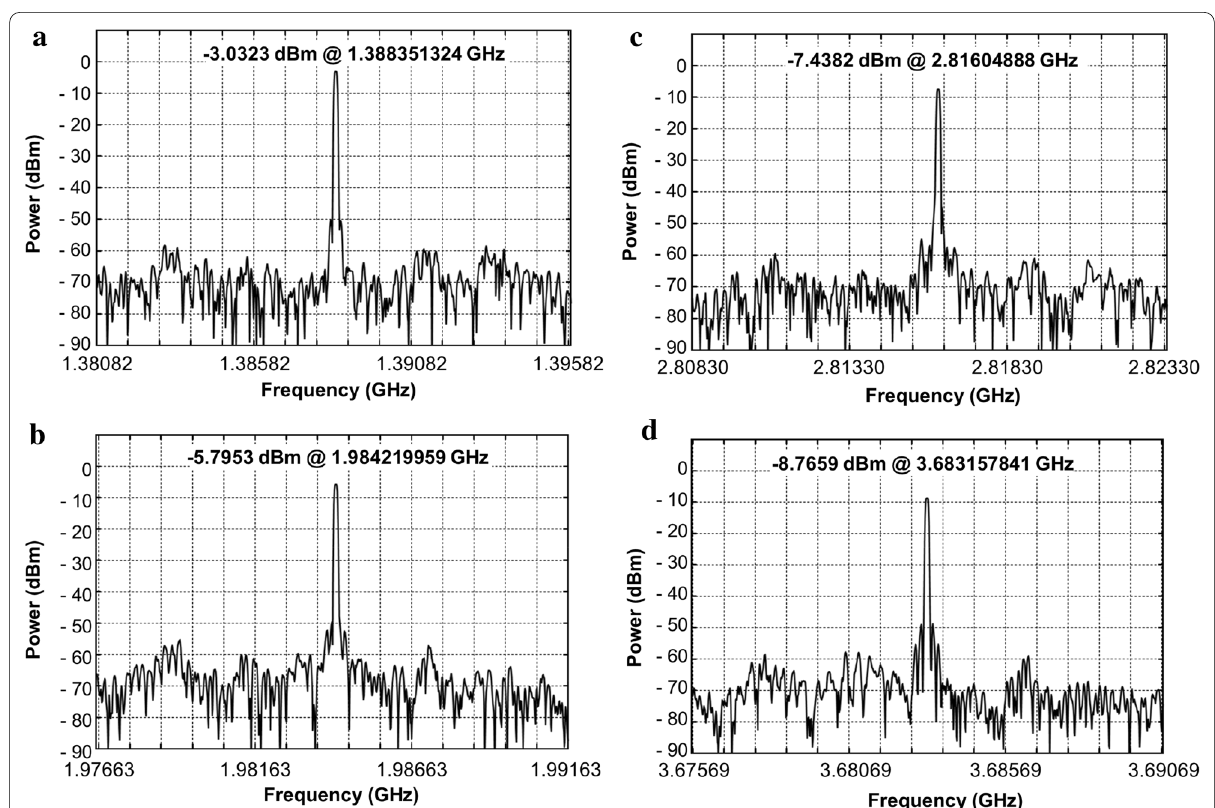
Fig. 7 Power spectra which show the oscillation frequency according to the operation of the tunable inductor. a When all switches were OFF, the oscillation frequency was 1.39 GHz and the power